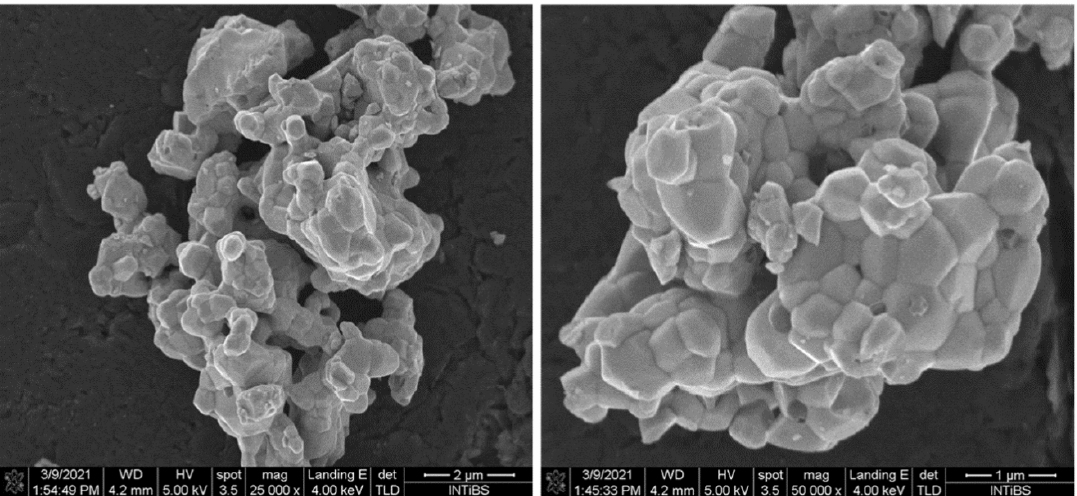
Figure 2. SEM images of sample La 2 MgTiO 6 :5% Er 3+ .